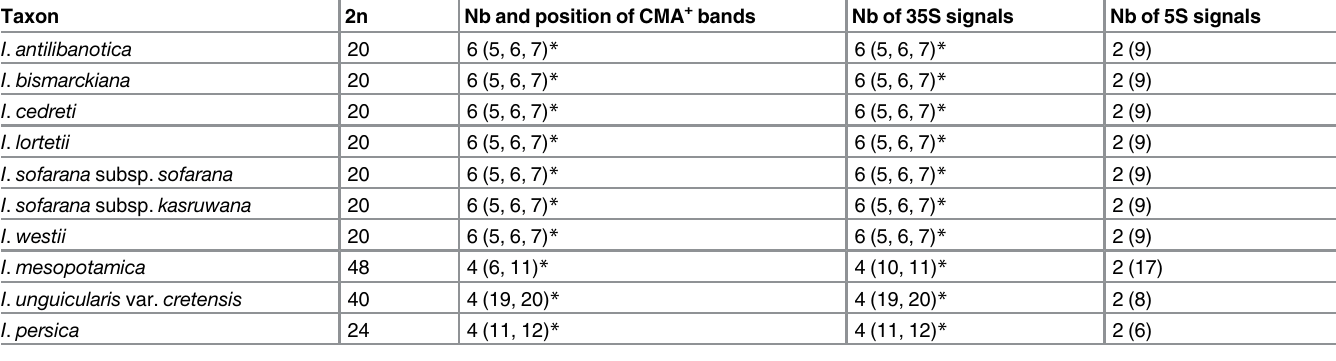
The karyotypes of investigated taxa were established for the first time using conventional mea- surements of chromosomes on several metaphase plates per species or population. Table 3. Synthesis of results concerning molecular cytogenetic approach of investigated Iris taxa.